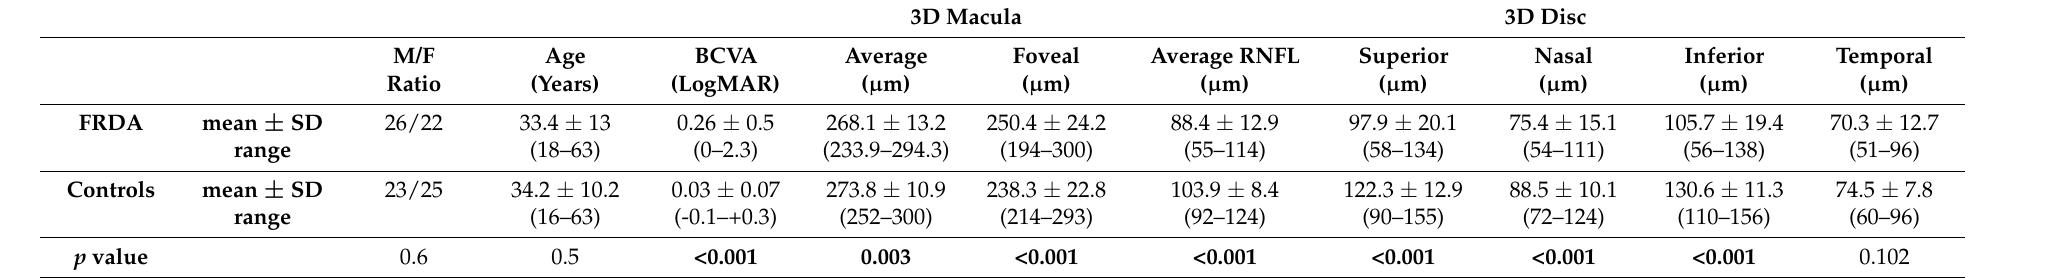
Table 3. Demographic and ocular characteristics of affected